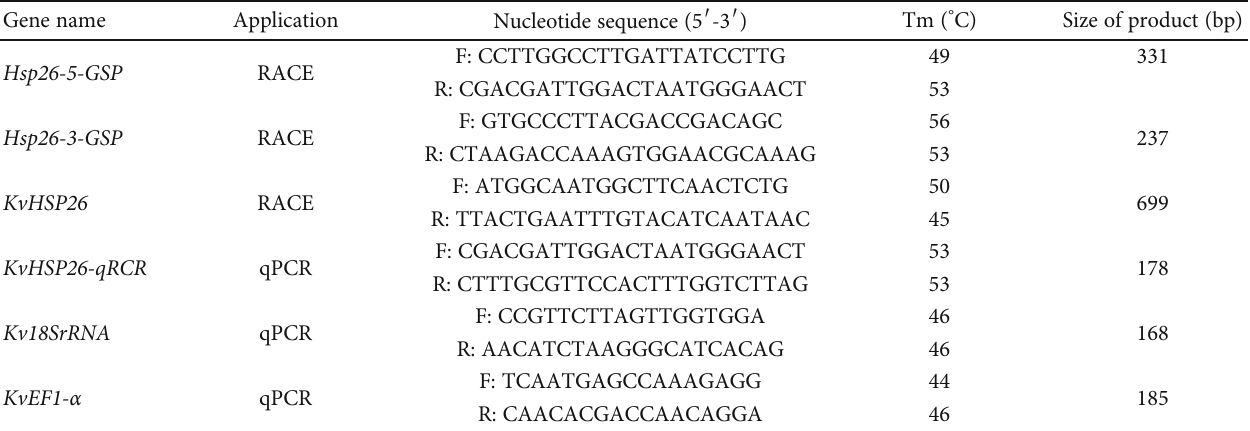
Table 1: Primers used in this